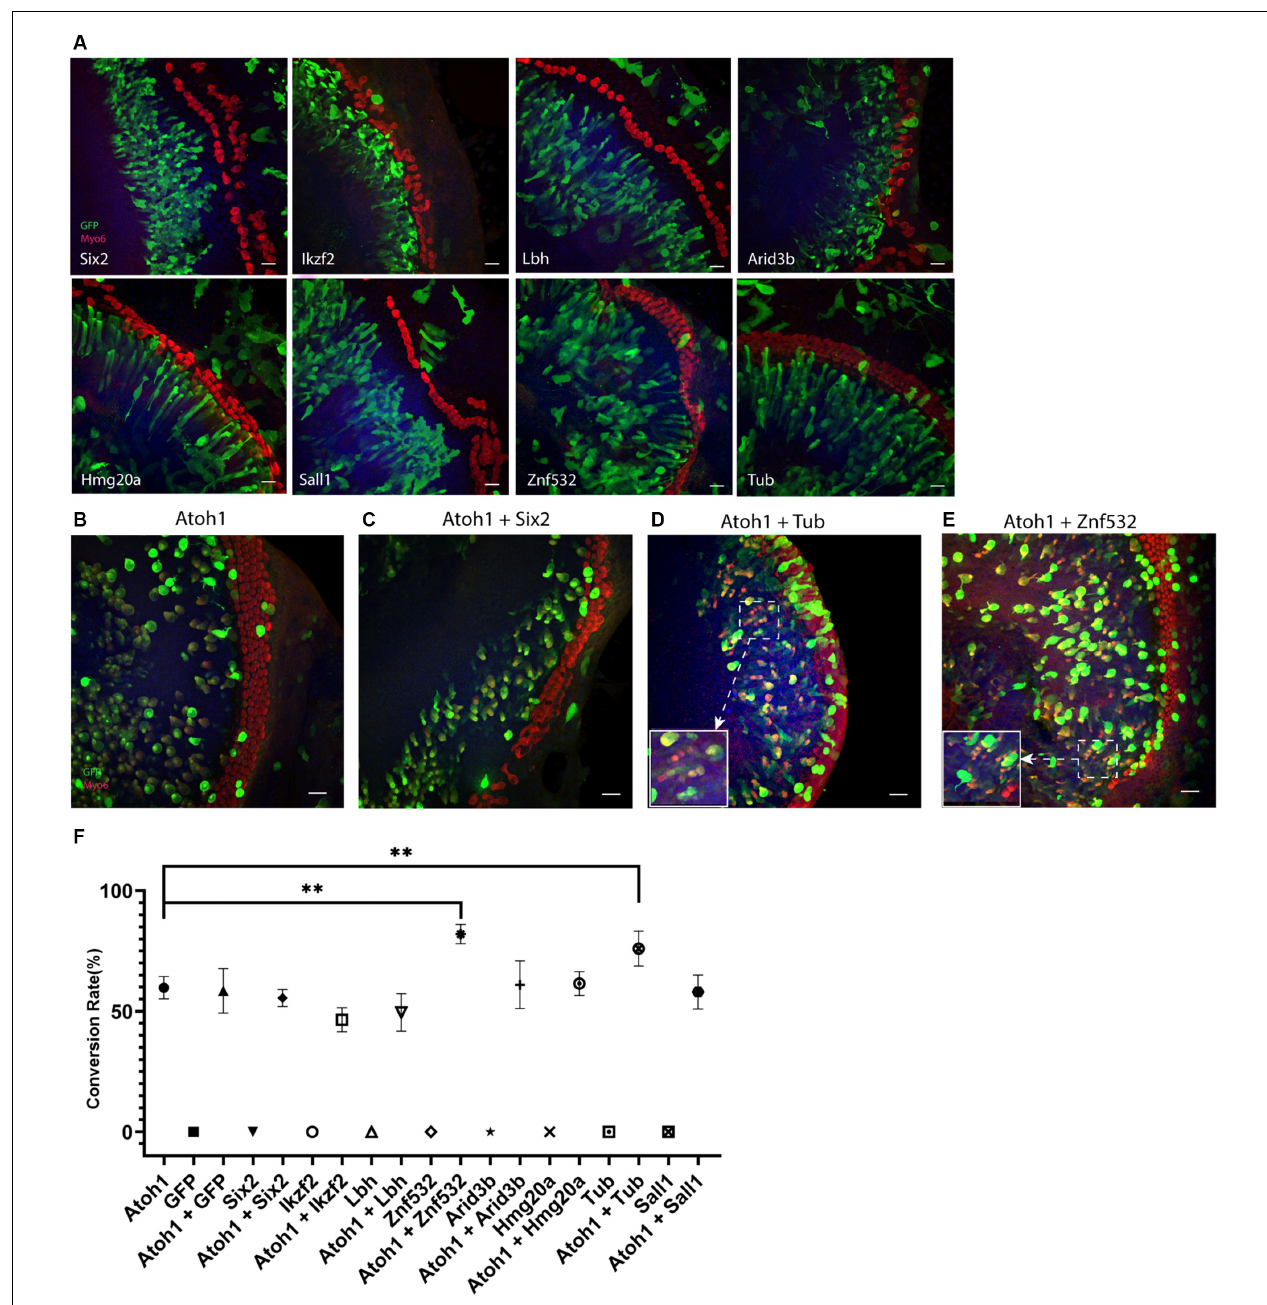
FIGURE 3 | (A) Forced transcription factor expression alone in lateral GER cells didn’t lead to any conversion. (B–E) Ectopic expression of Tub or Znf532 promotes the Atoh1 mediated conversion in lateral GER. (C) A representative negative control showing Six2 failed to promote the Atoh1 mediated conversion. (D,E) The explants shown were transfected with combinations of Atoh1 + Tub and Atoh1 + Znf532. (F) Statistical data showed that there are significant increases in the conversion rate with Atoh1 + Znf532 and Atoh1 + Tub compared with Atoh1 alone. Scale bar= 20 µ m. ** P < 0.01 by unpaired two-tailed Student’s t -test. Results are presented as the mean ±